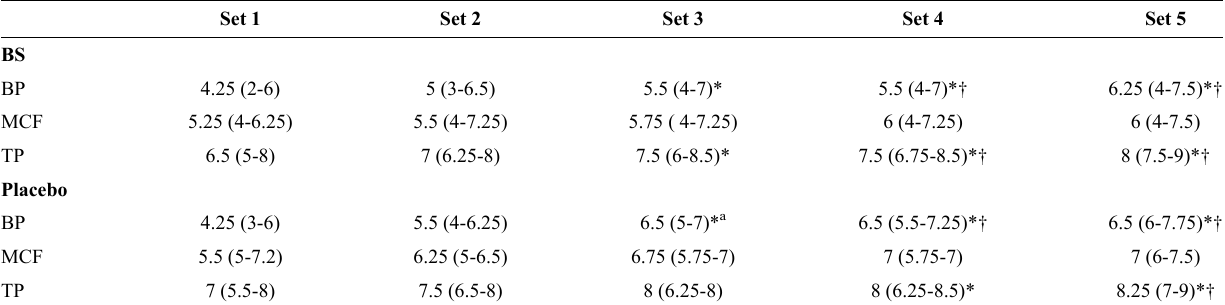
Table 1 - Rating of perceived exertion (RPE) values for each set on both supplementation conditions (Data are median [25%-75% of frequency]). Set